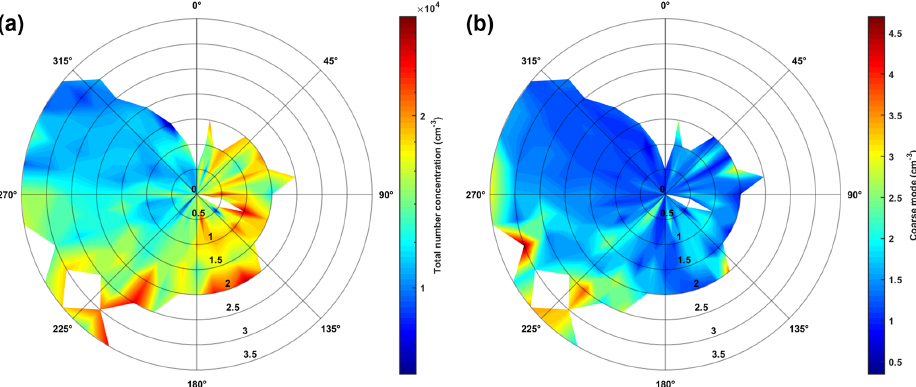
Figure 4. Wind rose diagram of total particle number concentration at a different direction (in the theta axis) and different wind speed (in the radical axis). Wind direction and wind speed data are grouped in every 10 ◦ and 0.5ms − 1 . Warmer colour represents higher total particle number concentration. (a) Total number concentration, log scale; (b) coarse mode, linear scale. Note the colour scales are